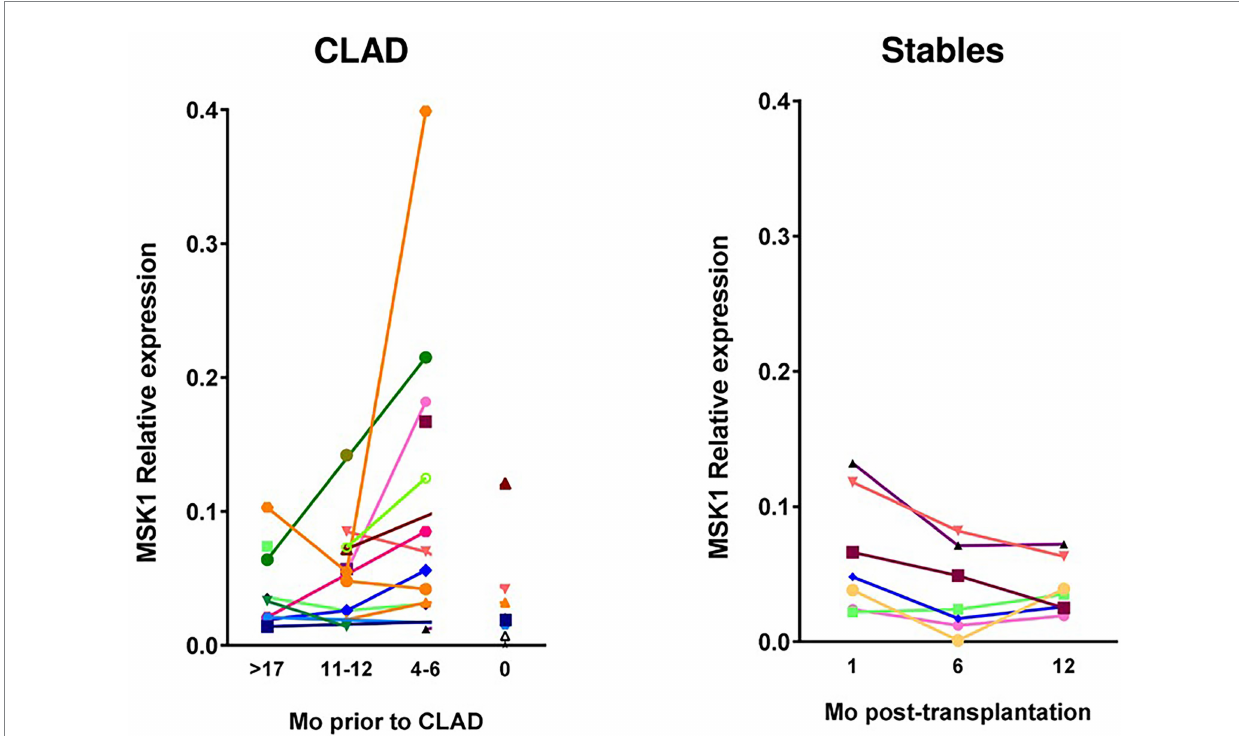
FIGURE 15 Evolution over time of MSK1 expression in CLAD and stable patients represented by relative RNA expression (1 biopsy per patient and time point). Dots represent value for each patient’s biopsy and line the evolution of expression for each patient over time: for CLAD patients as months before diagnosis, and for stable patients as Mo posttransplantation. CLAD, chronic lung allograft dysfunction; Mo, months; MSK1, mitogen-and stress-activated kinase 1, adapted from (30).